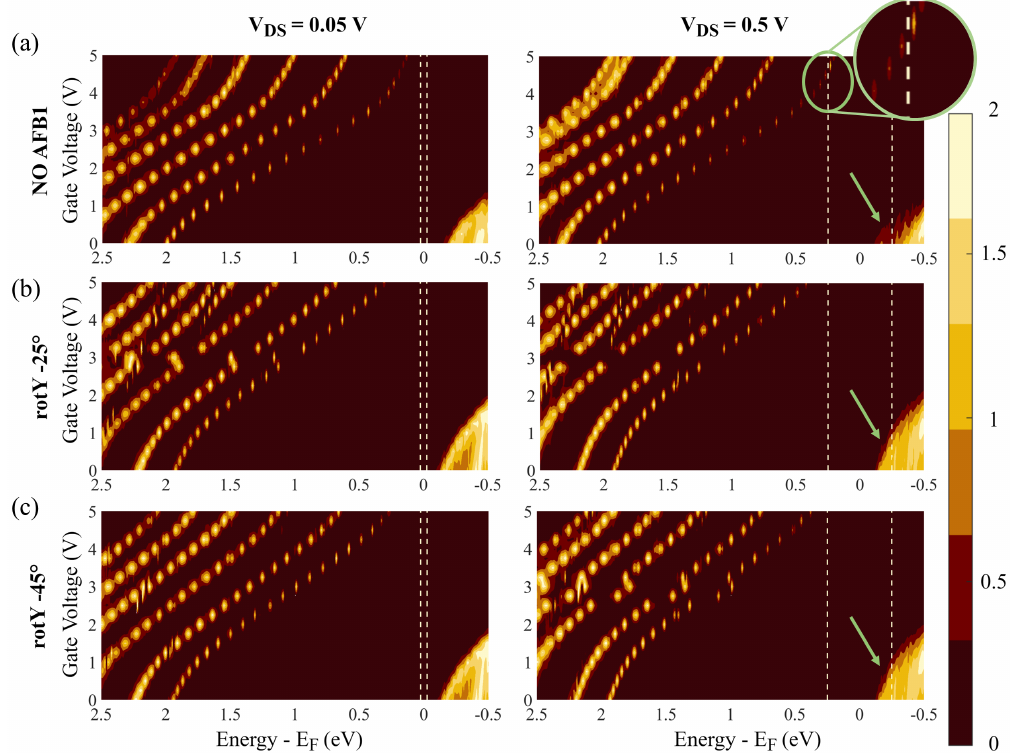
Figure 8. Computed contour diagrams of TS ( E , = and V GS ) as a function of gate voltage, V GS , and energy, E , for low (left side) and high (right side) values of V DS (0.05 V and 0.5 V, respectively). The pale yellow dashed lines denote the bias window, − qV DS , whereas the green arrows indicate the HOMO transmission peaks entering the BW . ( a ) TS ( E , V GS ) of the Au-8PyDT sensor in the absense of AFB1. The green inset is an enlargement of the contour diagram showing the LUMO peak entering the BW; ( b ) TS ( E , V GS ) of the Au-8PyDT sensor in the presence of the target in the configuration rotY − 25 ◦ ; ( c ) TS ( E , V GS ) of the Au-8PyDT sensor in the presence of the target in the configuration rotY − 45 ◦